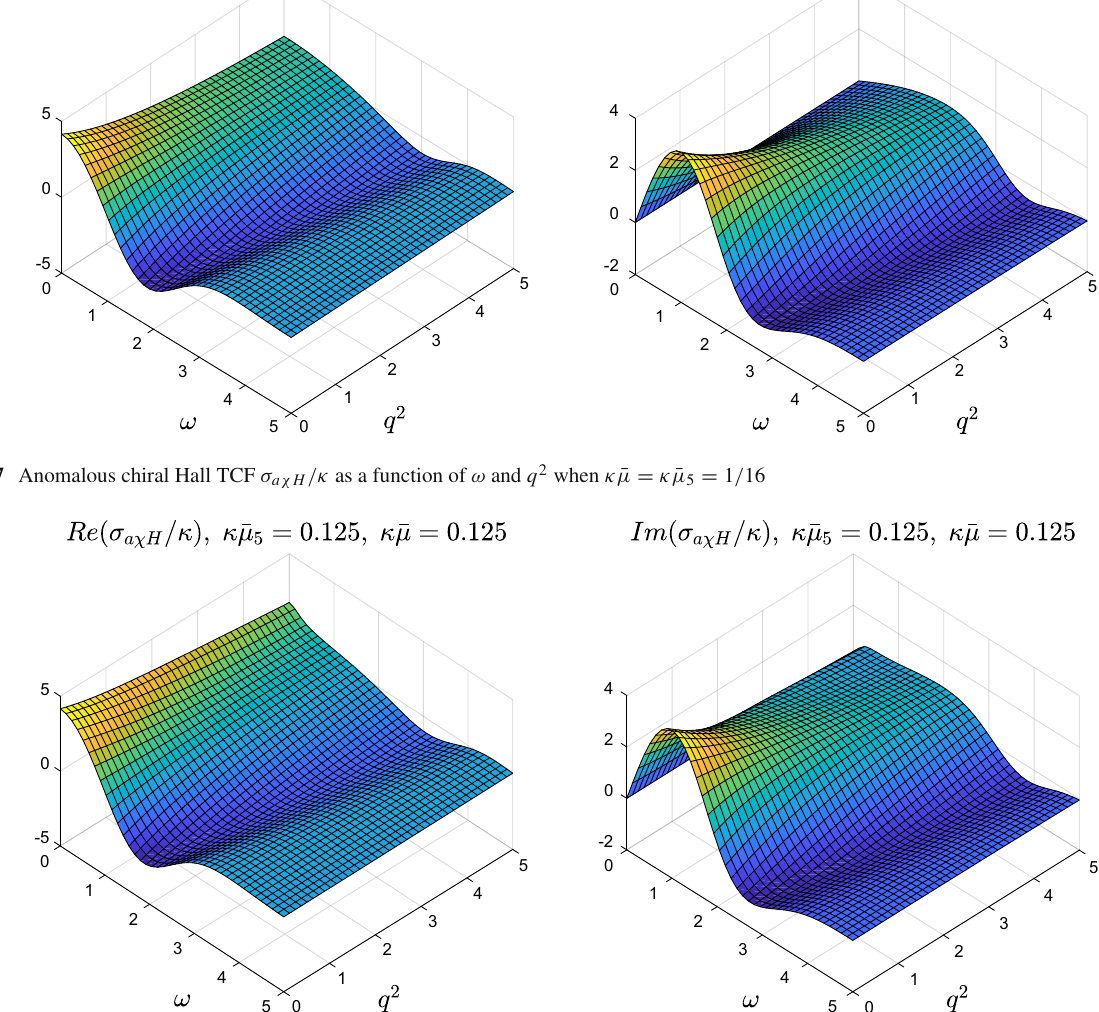
stands for DC limit of D H H